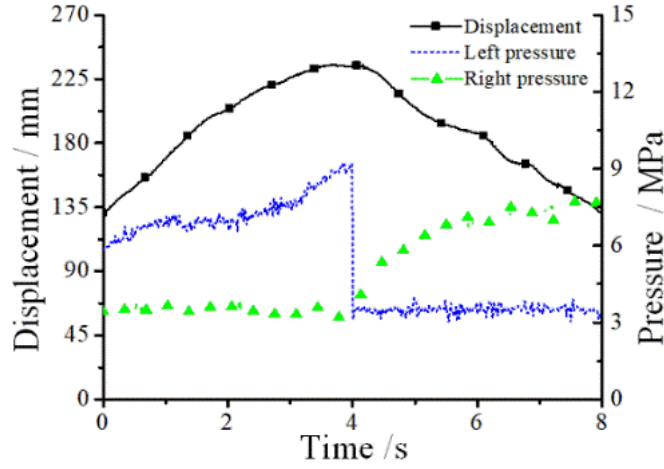
Figure 11. Test curves of steering with a normal load.